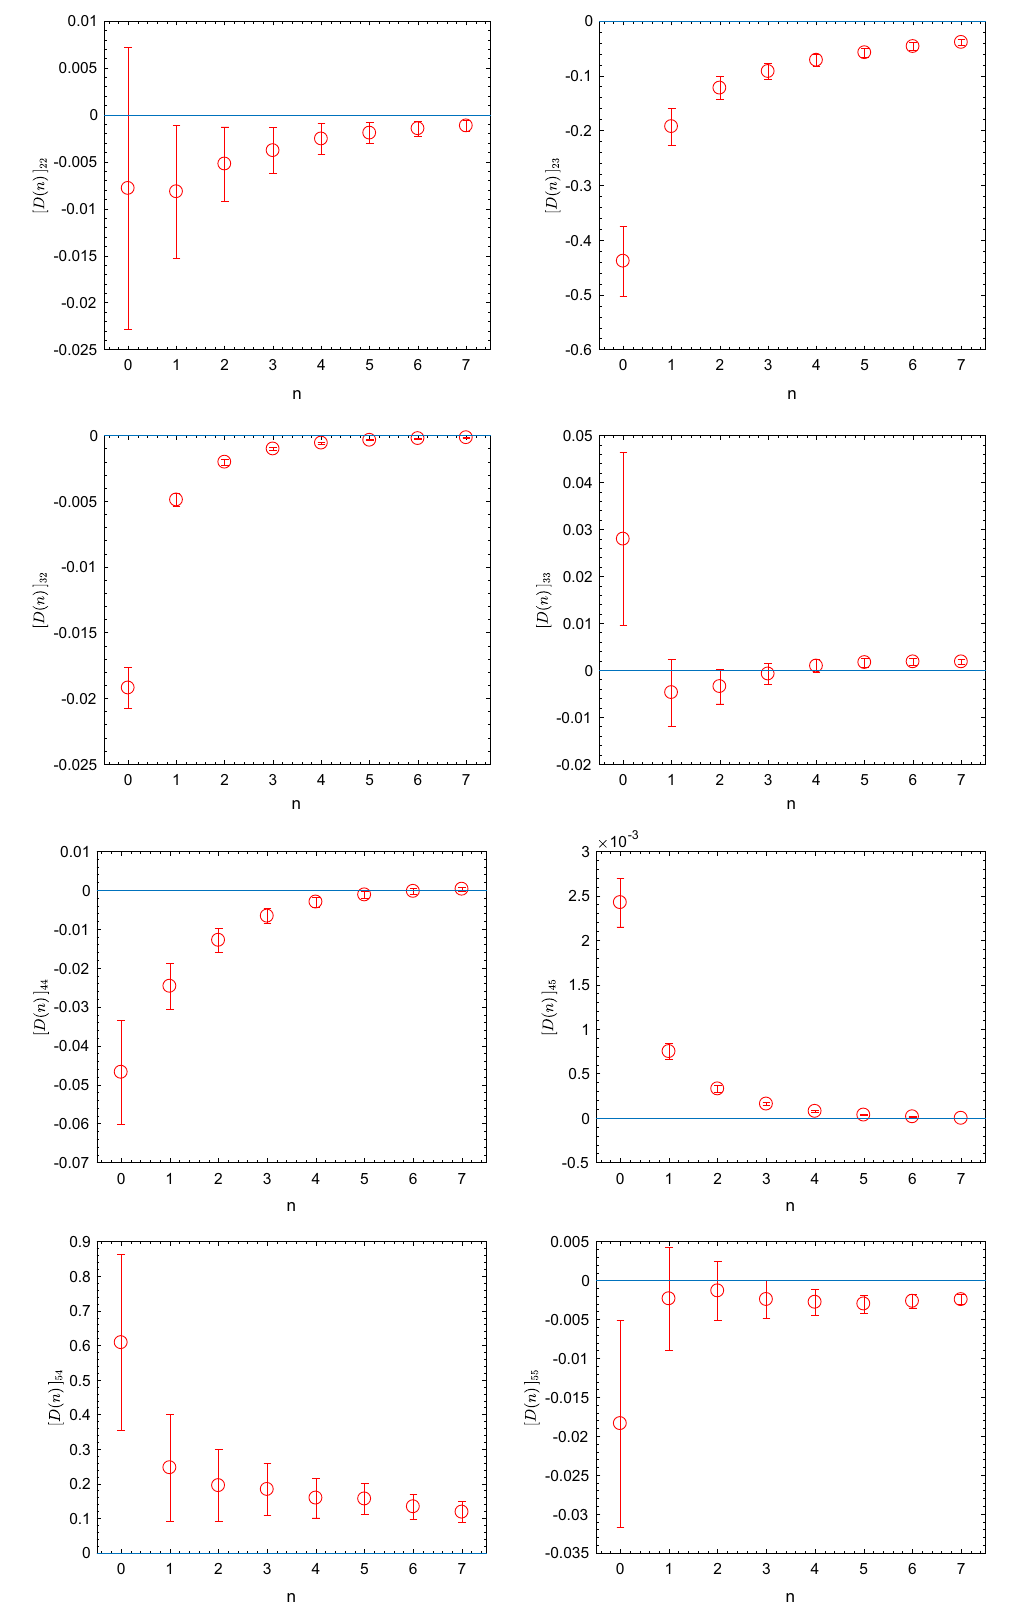
, Q + } (top) and { Q + 2 3